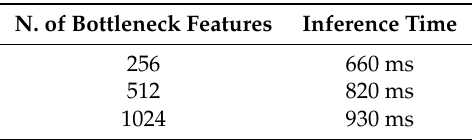
Table 4. Inference times for different-sized Mini U-Nets for garbage detection.